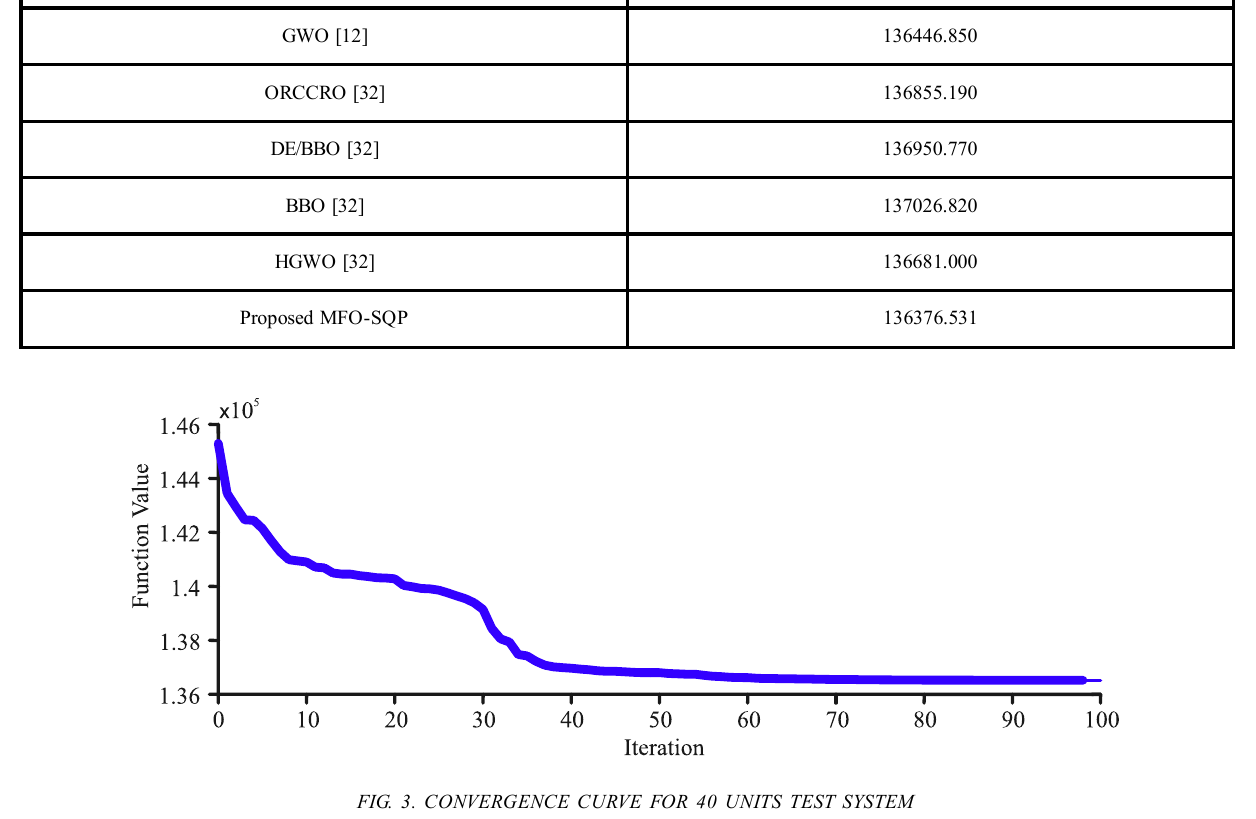
FIG. 3. CONVERGENCE CURVE FOR 40 UNITS TEST